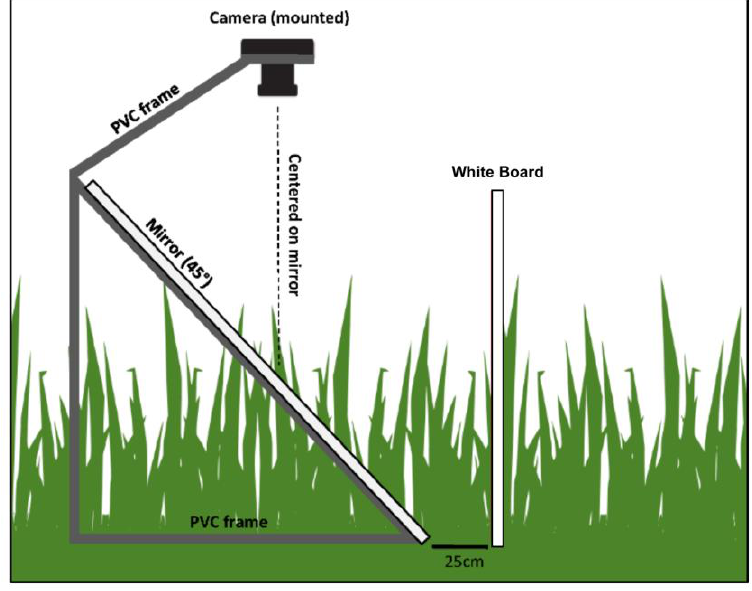
Figure 2. Vertical accuracy apparatus (adapted from Neumeier 2005) [36].